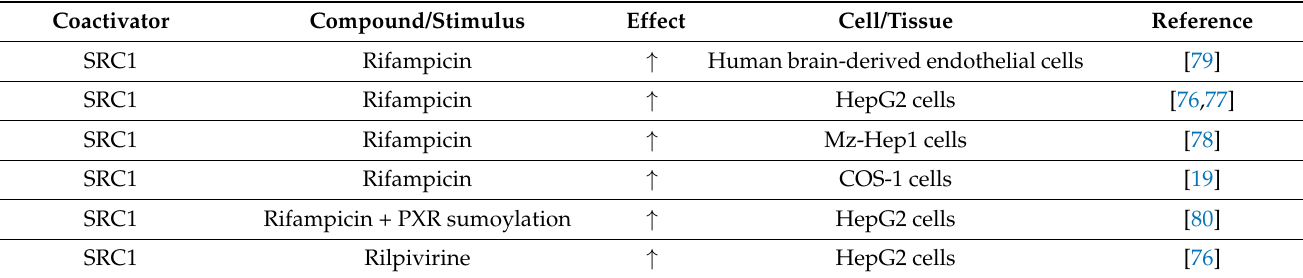
Table 1. Factors modifying the interaction